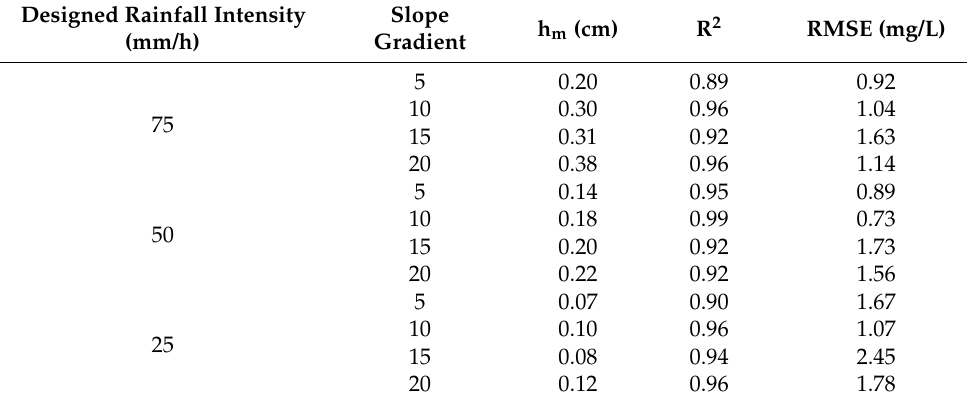
Table 4. The mixing depth (h m ), R 2 and RMSE obtained by curve-fitting the results of the solute transport model under different rainfall intensities and slope